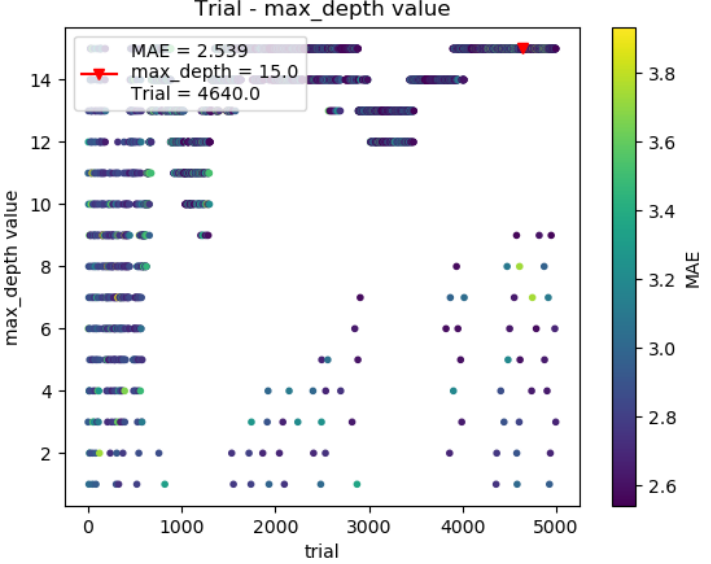
Figure 4. Evolution of maximum depth value and its corresponding MAE across the